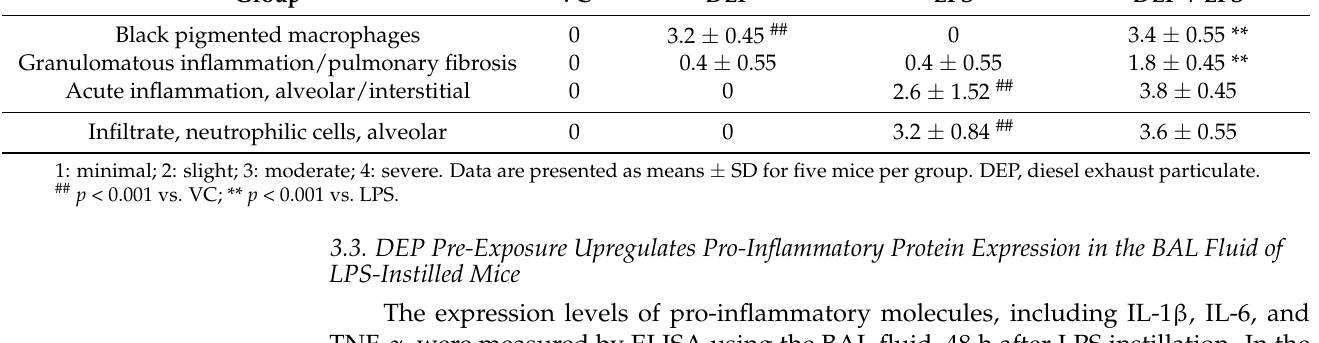
Figure 3. ( A – D ) Cellular changes in the bronchoalveolar lavage (BAL) fluid and ( E ) representative hematoxylin and eosin (H&E) and Masson’s trichrome-stained images of the lung sections from the vehicle control (VC), DEP, LPS, and DEP pre-exposed and LPS-instilled (DEP + LPS) groups. Black, red, and blue arrows indicate particle-pigmented alveolar macrophages, inflammatory infil- tration, and collagen deposition, respectively. Scale bars = 50 μ m. Data represent means ± SD (n = 5 per group). # p < 0.05 vs. VC, * p < 0.05 vs. LPS group. Table 1. Histological scores for the lung of mice in different groups. Table 1. Histological scores for the lung of mice in different groups. Group